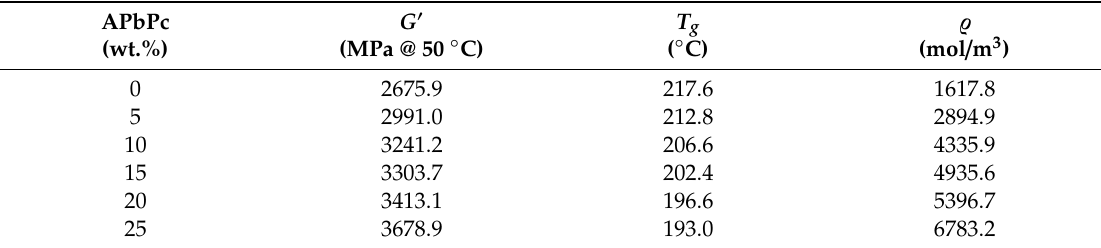
Figure 9. Storage modulus ( A ) tan delta ( B ) of P-ddm / APbPc copolymer at di ff erent mass fraction of APbPc. Table 4. Summary of dynamic mechanical analysis (DMA) data and crosslinking density values of P-ddm / APbPc copolymer at di ff erent mass fractions.